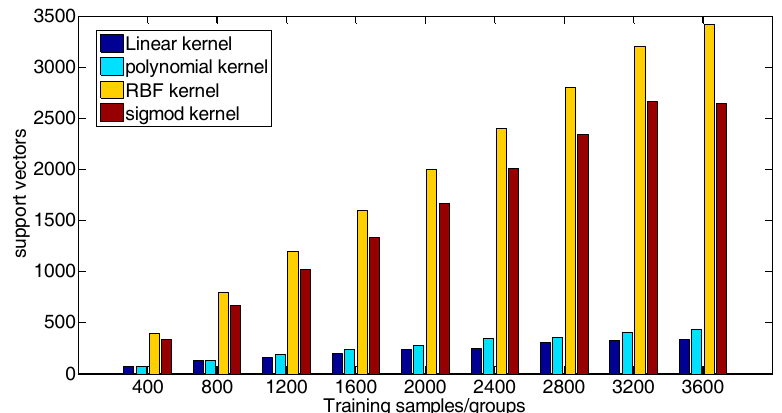
Figure 7. Number of support vectors for four kernel functions.